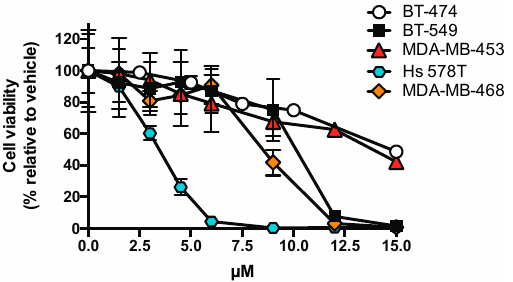
Figure 3. Dose ‐ dependent alteration of cell viability. Human breast adenocarcinoma cell lines were treated with increasing concentrations of 3 . Twenty four hours after plating, cells were incubated with 0–15 μ M 3 for 48 h. Cell viability relative to vehicle control was measured by MTS assay. The results represent the mean ± standard deviation of 6 independent determinations.